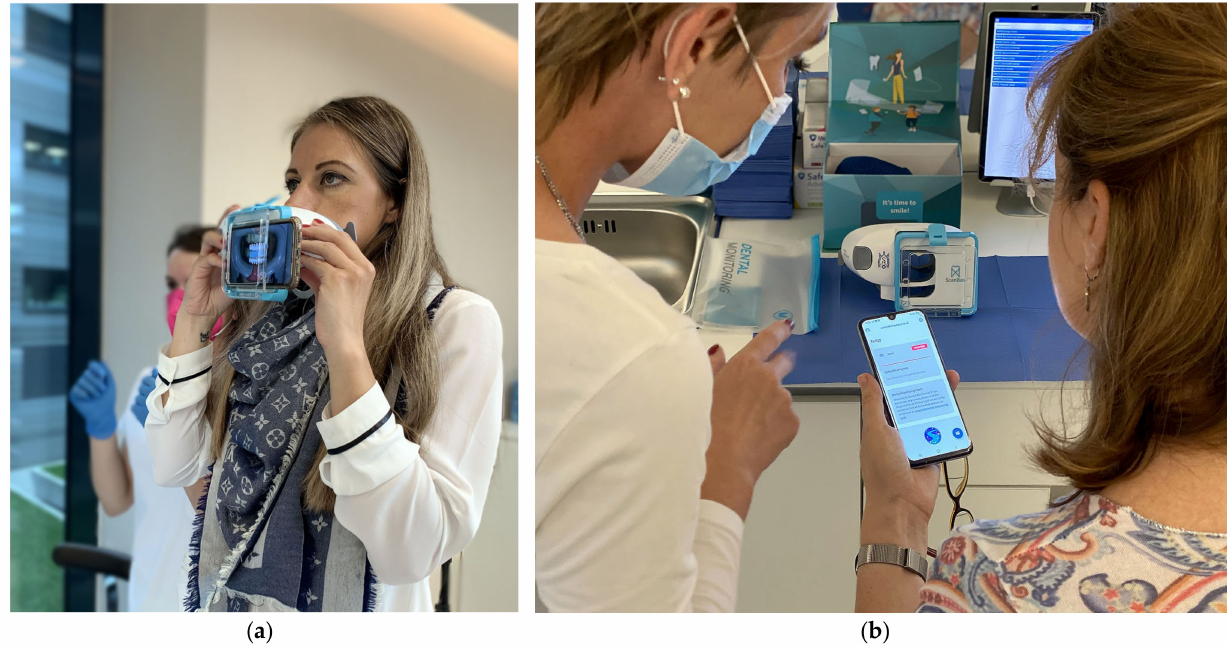
Figure 1. Introduction of Dental Monitoring ® (DM): ( a ) Patient holding scan-box looking into the mirror, instructed by nurse, is scanning her first intraoral scan with her own mobile. ( b ) DM has its own app that is used for requests, uploading and reporting of the scans. Its first use is usually also instructed by nurse. The photo was taken for purposes of this article and is published with full written consent of the